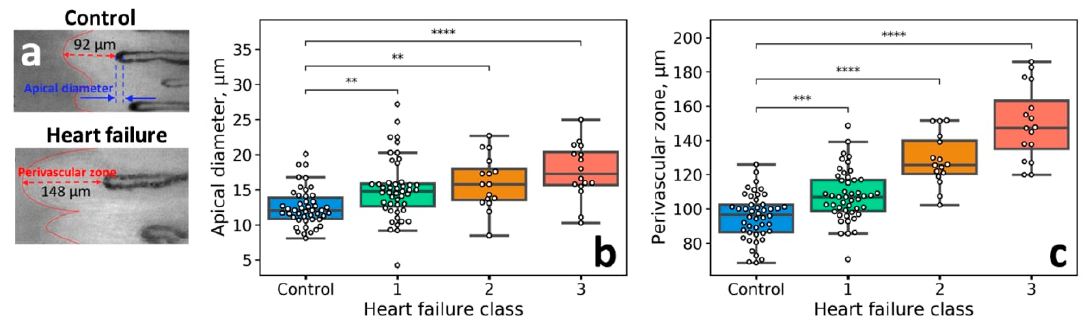
Figure 3. ( a ) Representative images of the nailfold capillaries for the control subject (upper panel) and patient with HF (NYHA class III, lower panel), adapted from [13]. The widths of the PZ are shown with a red dashed line. The dependence of the ( b ) apical diameter, and ( c ) PZ size on the NYHA HF class. The statistical significance was estimated using Kruskal-Wallis test with Bonferroni correction (* p < 0.05; ** p < 0.01; *** p < 0.001; **** p < 0.0001, ns—not significant).